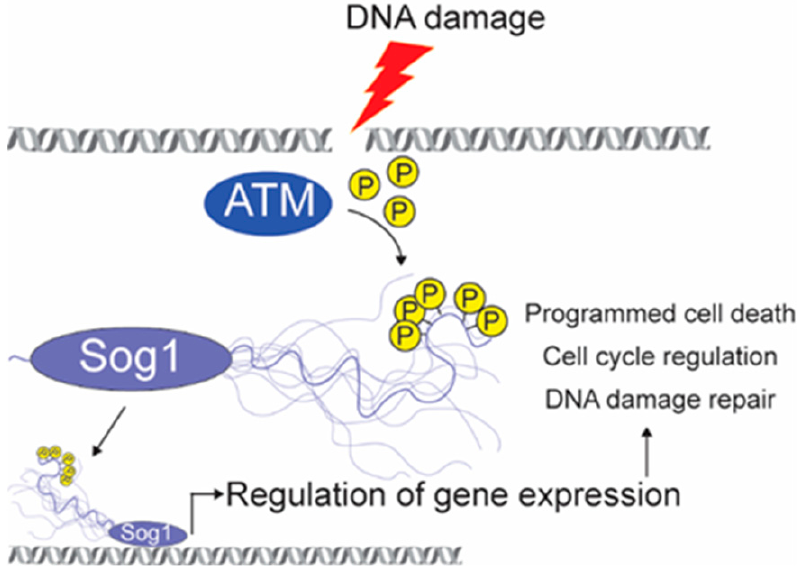
Figure 3. Regulation of biological function by PTMs of plant TF IDR as in the case of SOG1 phosphorylation in the DDR. Upon DNA damage, ATM (kinase) is activated and phosphorylates five SQ motifs in SOG1. SOG1 regulates the expression of genes associated with DDR, cell cycle regulation, and programmed cell death. The mechanisms of this activation of SOG1 remains unknown, but phosphorylation of the SOG1 IDR may affect the exposure of the DBD through long-range electrostatic interactions between the IDR and the DBD.